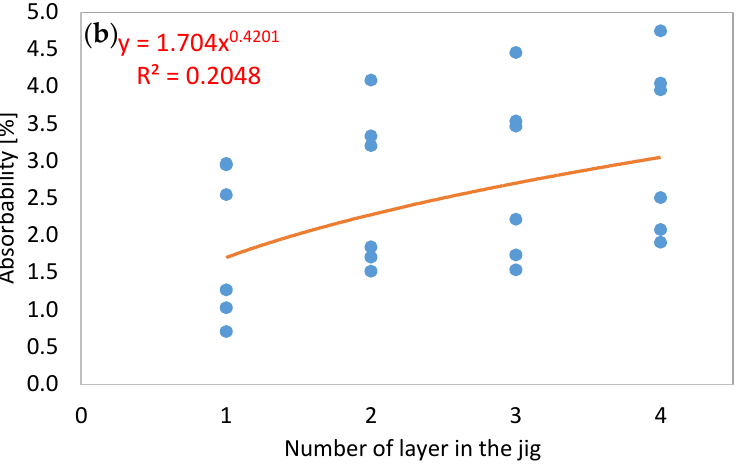
Figure 6. Model of separation for density ( a ) and absorbability ( b ). More precise modeling results can be obtained when enrichment products obtained from regular and irregular feed material will be analyzed separately. Results for density was presented in Figure 7, while models for absorbability in Figure 8. Relationship between density and number of enrichment product for regular particles shows high level of accuracy (R 2 = 0.935) and is statistically significant. Lower statistical significance shows model for irregular particles but it is also significant on the probability level 95%. In the case of absorbability (Figure 6b) the model is statistically significant only for irregular particles. However both models show the similar type of relationship. Tendency in density decreasing together with increasing the number of layer describes well a hyperbola, while absorbability can be characterized through exponential model, with the power at x less than one.